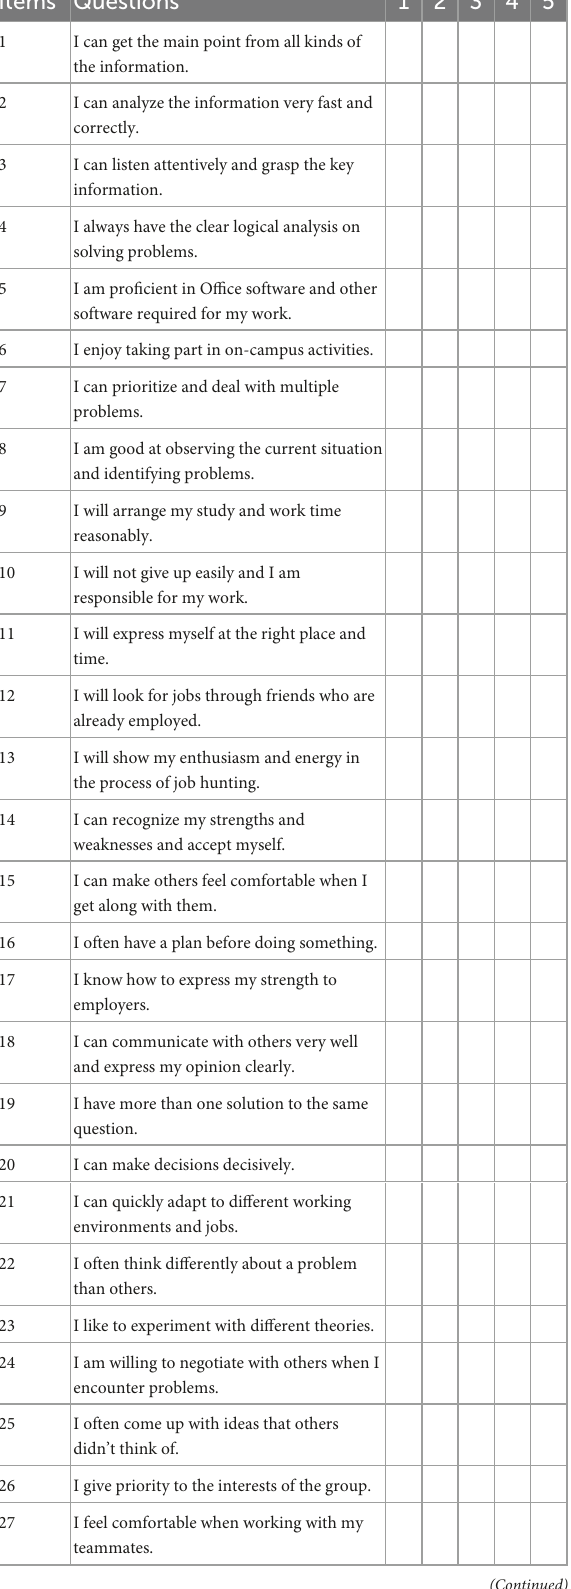
TABLE 1 Survey on employability of college students. Items